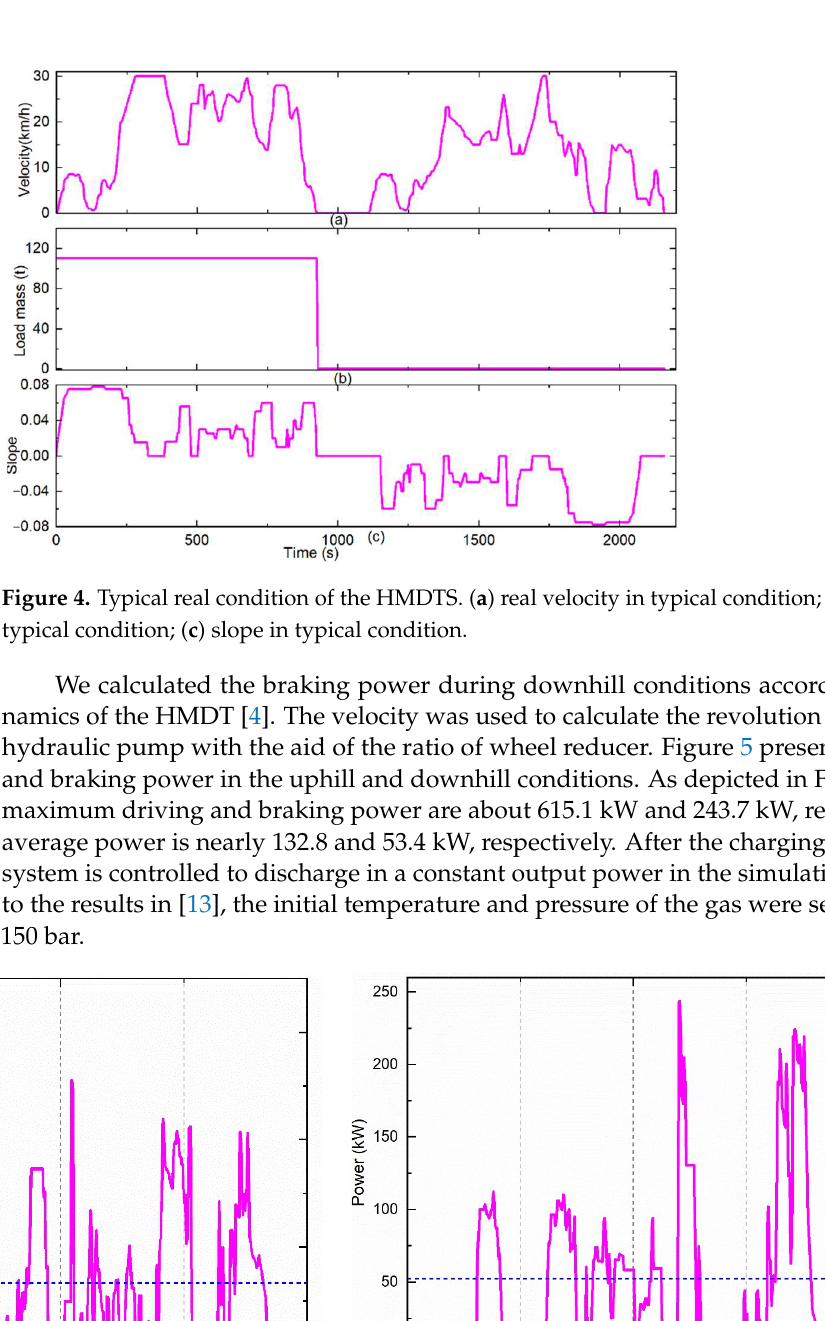
Figure 5. Power in real test conditions. ( a ) driving power in uphill; ( b ) braking power in downhill.